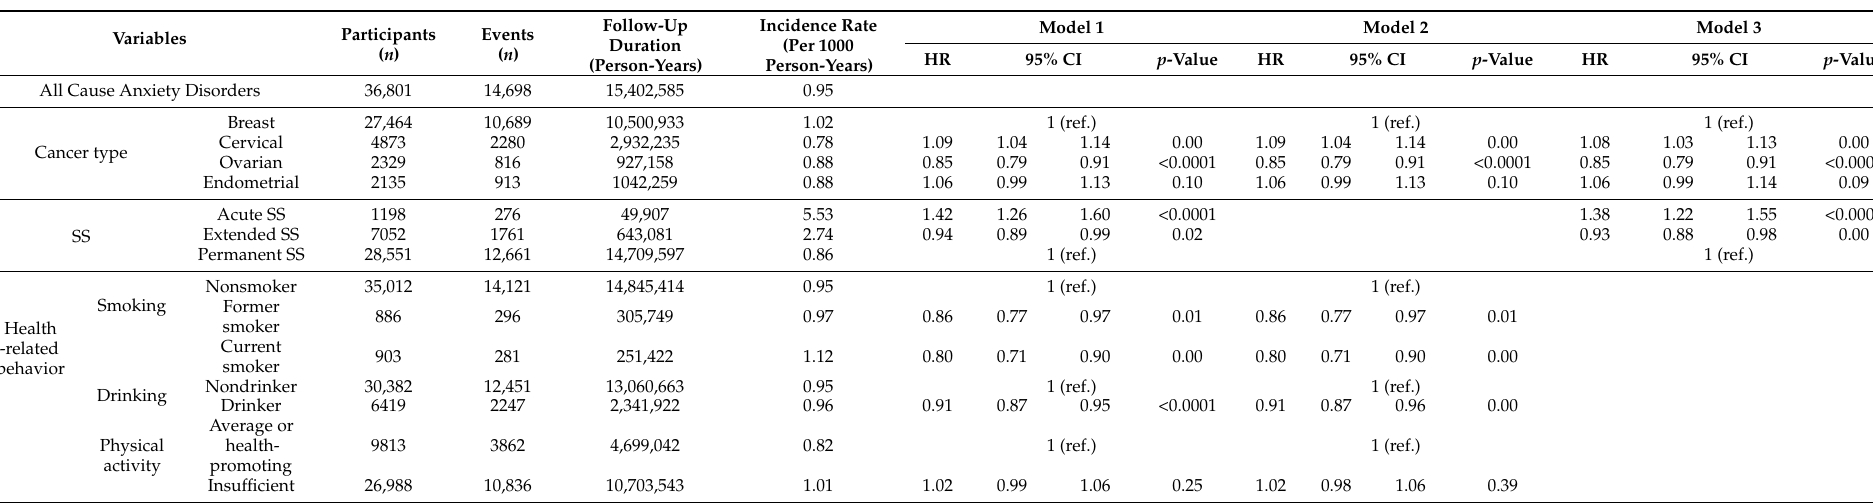
Table 2. Hazard ratios and 95% confidence intervals of anxiety disorders based on cancer survivorship stage and health